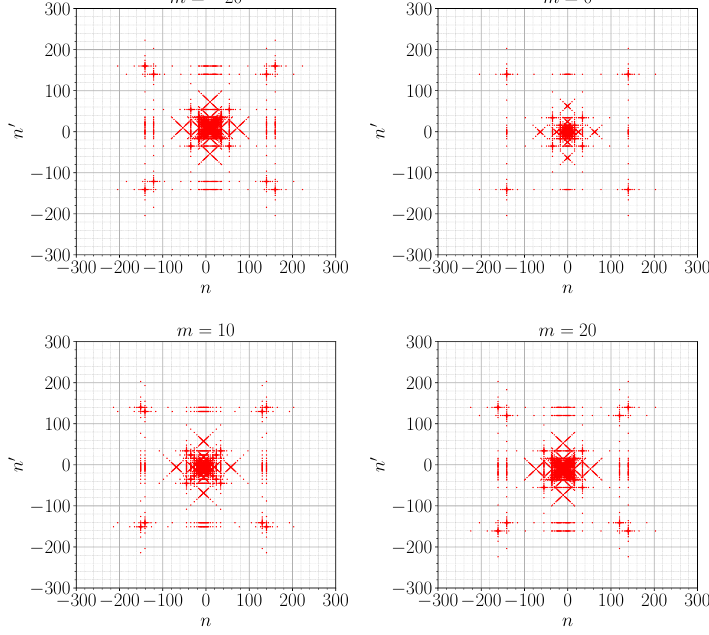
Figure 3: Sampling points generated in the particle-hole notation independently for m = − 20,0,10,20 ( Λ = 100 and N